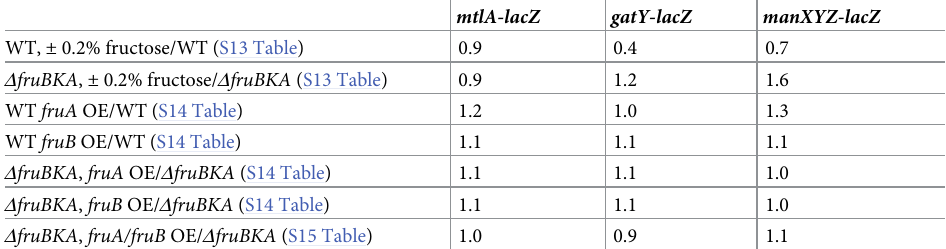
Table 3. Ratios of the responses of lacZ fusion-bearing strains to various conditions and genetic backgrounds (S13–S15 Tables). WT = wild type, BW25113; OE = overexpression; Δ fruBKA = deletion of the entire fruBKA operon, also called triple mutant, TM. All strains were grown in LB medium to which 0.2% fructose was added, only for the first two entries as indicated. The remaining entries reveal the consequences of the overexpression of specific fru genes or gene combinations on lacZ- fusion gene expression. In no case were the changes significant, suggesting that the pres- ence of fructose in the growth medium or the overexpression (OE) of specific fru genes, or the entire fru operon, did not influence expression of the mtl , gat , or man operons.